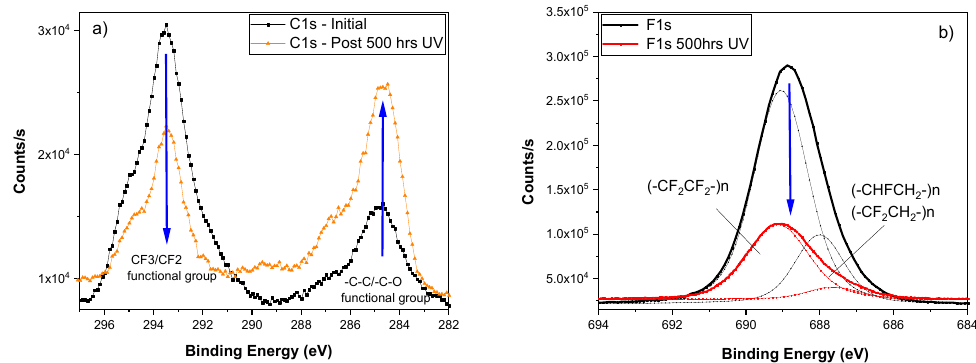
Figure 3. XPS analysis performed on hydrophobic coating A shows the change in ( a ) C1s and ( b ) F1s high resolution peaks for as-deposited coupons and after 500 h of UV exposure.